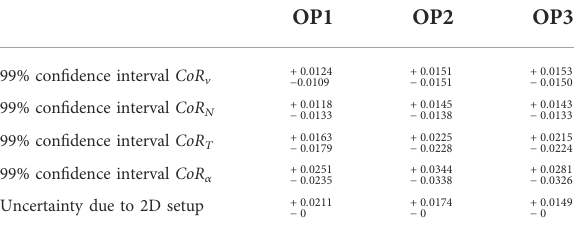
TABLE 3 Summary of dominant measurement